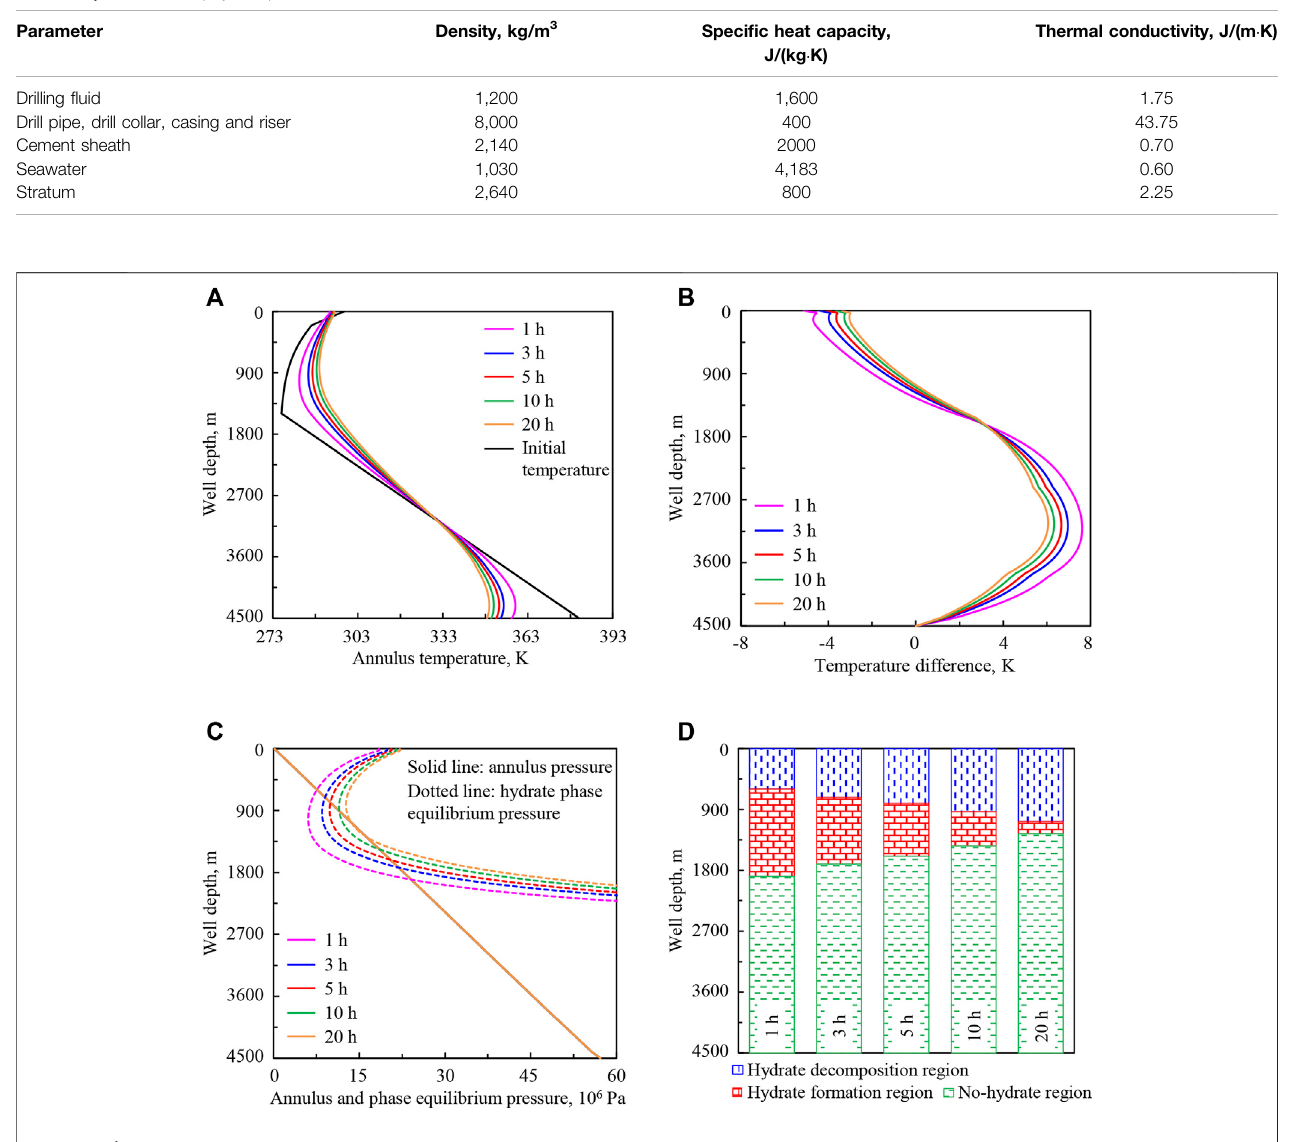
Frontiers in Energy Research |